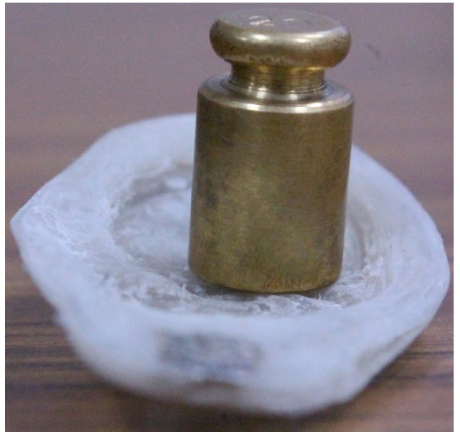
Figure 3. Example of pressure